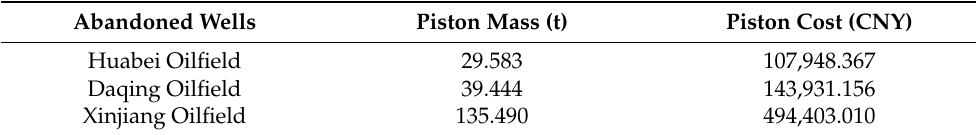
Table 8. Piston costs of gravity energy storage systems in abandoned oil-gas wells in the three considered